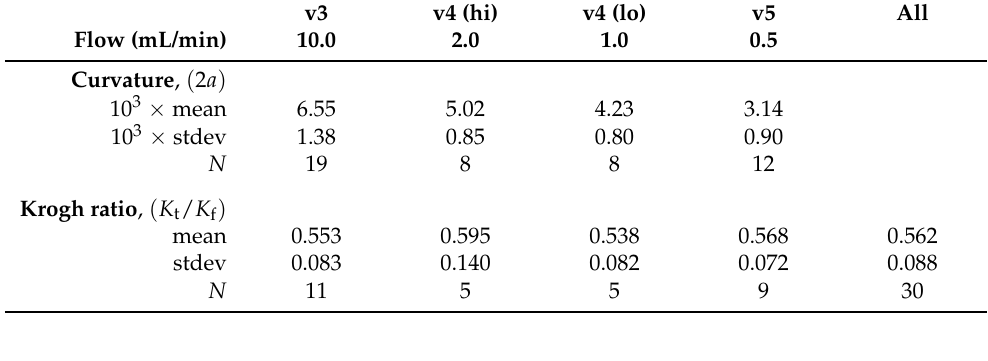
Table 4. Sensitivity of profile curvature and Krogh ratio to variations in aCSF flow rate. Column headings identify the datasets used for computing statistics; the v4-dataset is partitioned into its high- and low-flow subsets. Perfusion rates decrease from left to right across the columns. Krogh statistics summarise the x = L (lower interface) retrievals, but note that candidate Krogh ratios that exceed the ( K ) max = 0.725 cutoff have been excluded (see Table A1). f / K f